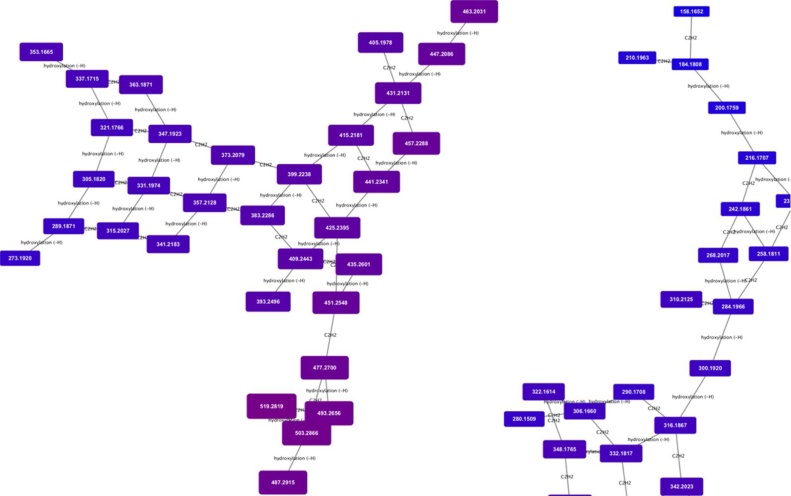
Transformation network focusing on hydroxylation and ethyl group extension. Note that the masses, annotated as lipids and fatty acids, organise into grid patterns linking compounds related by H -> OH and addition or subtraction of C2H2. Nodes are colour and size coded by mass, and it is possible to see the gradual shift from smaller to larger features across the networks.